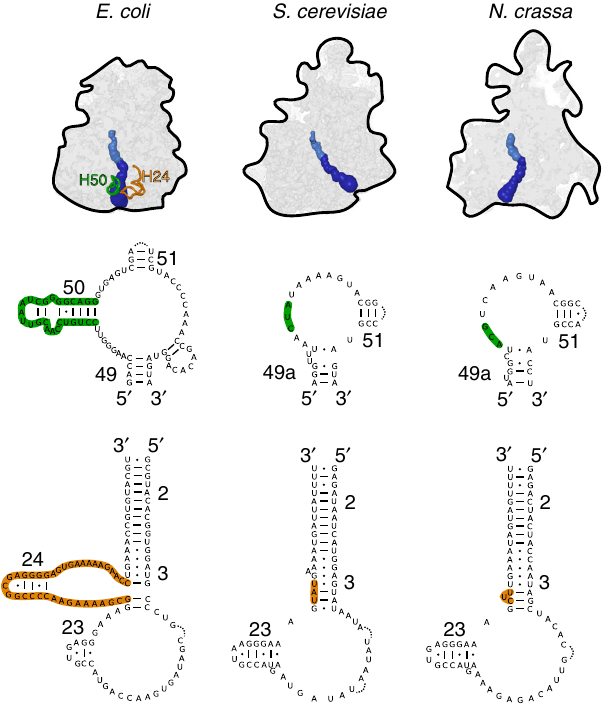
Fig. 5 Comparison of the tunnel paths and the rRNA secondary structure elements involved in its formation. The different tunnel paths are shown for the bacterial ribosome ( E. coli ) and the mitoribosomes from S. cerevisiae and N. crassa . The locations of the rRNA helices H24 (orange) and H50 (green) are indicated. The secondary structure diagram for H24 and H50 regions features their deletion from the sequence of the mitochondrial DNA in S. cerevisiae and N.